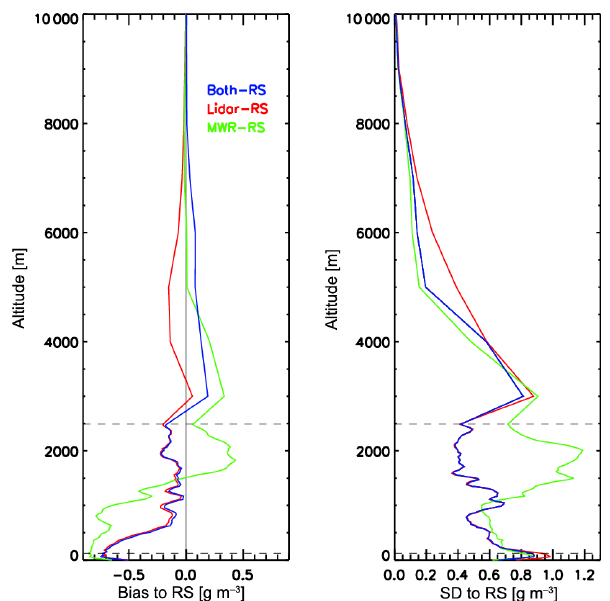
Figure 6. Mean and standard deviation of the difference between the 18 clear sky radiosondes: MWR (in green), RL (in red) and the combination of both (blue). The dashed horizontal lines enclose the region where the lidar data are